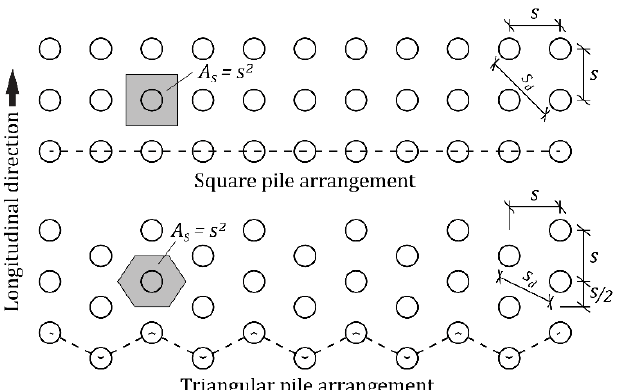
Figure 3. Square (previous standard) and triangular (current standard) pile arrangements. Pile rows in x- and y-directions are marked with dashed lines.